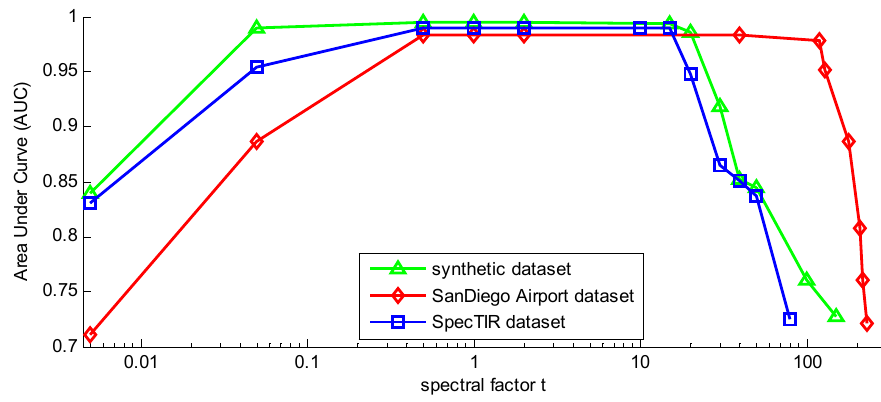
Figure 11. The AUC of WSSKRX with the changing spectral factor t on the San Diego Airport dataset, SpecTIR dataset and synthetic dataset.